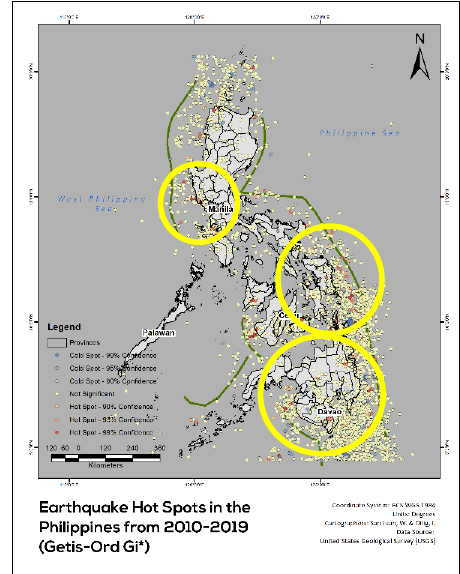
Figure 15. Earthquake Hot Spots in the Philippines from 2010 to 2019 (Getis-Ord Gi*)